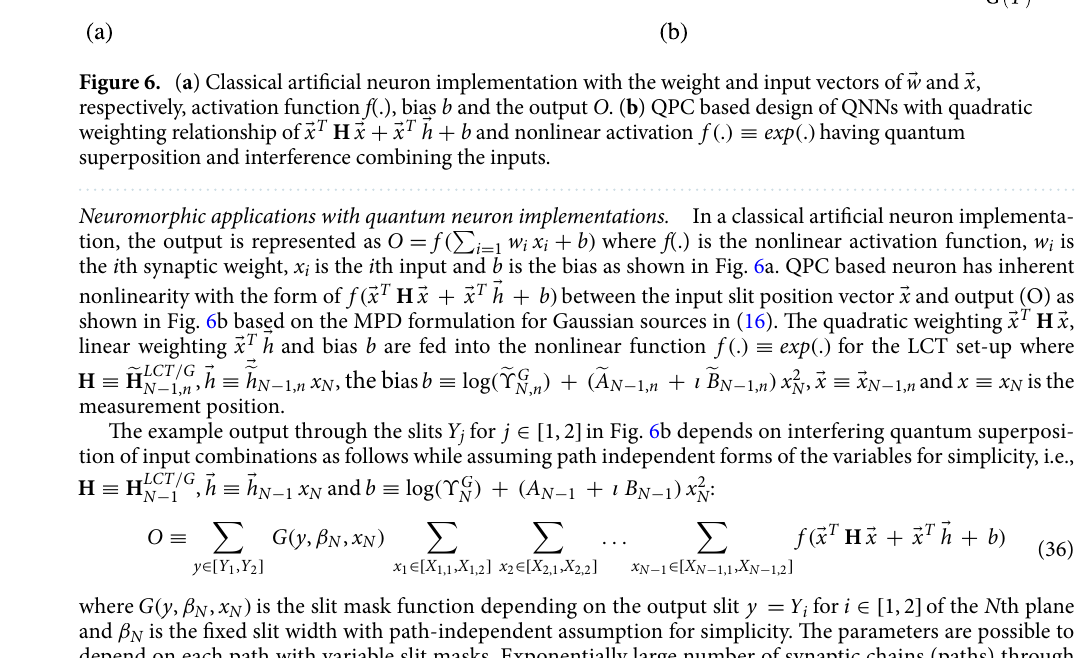
x T H x x T h b and nonlinear activation f ( . ) � � � + � +